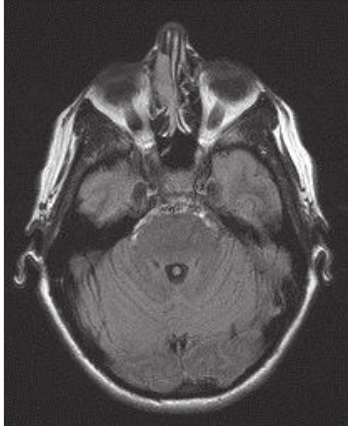
Figure 1: T1-weighted axial MRI demonstrating the mass in the right nasal cavity.